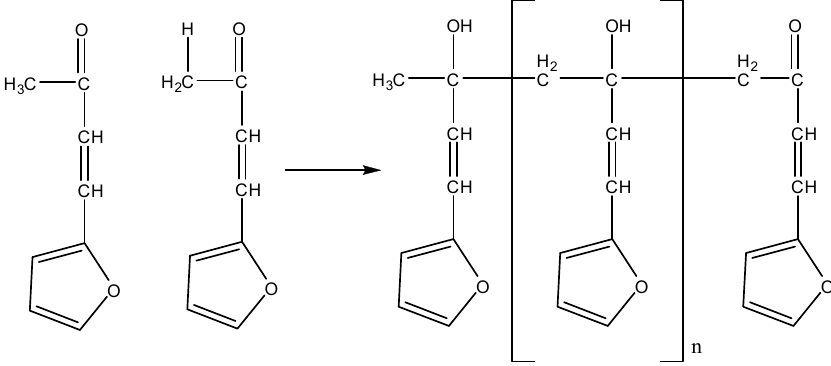
Scheme 5. Reaction of forming furfural-acetone resin.